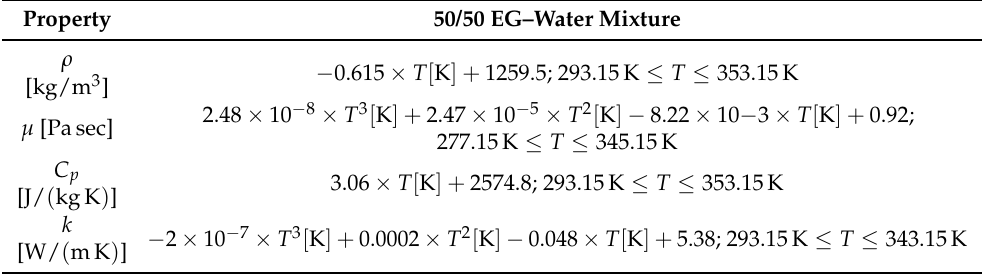
Table 2. Temperature dependent thermo-physical properties of 50/50 ethylene glycol (EG)–water used for cold-plate cooling of the battery module [25,26].